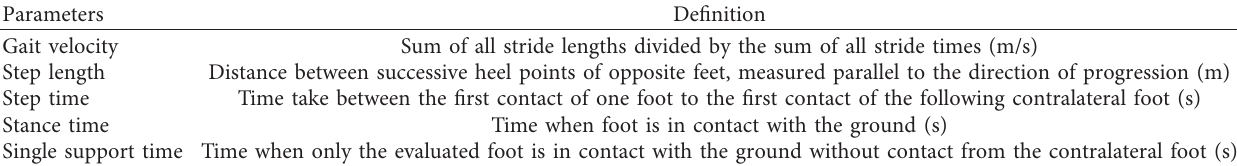
Table 1: Definitions of the five parameters used in the Enhanced Gait Variability Index calculation.